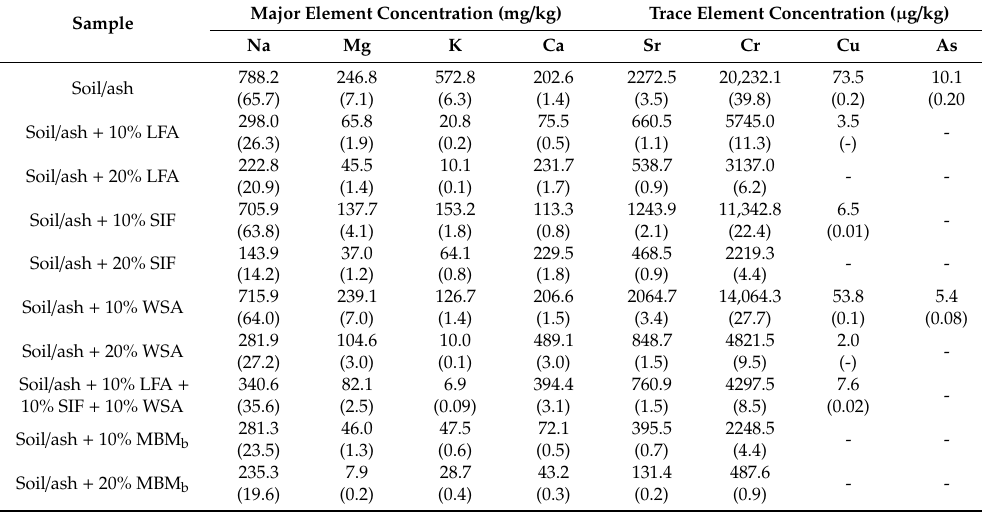
Table 5. Cumulative element concentrations and (%) mass leached in the leachates with stabilizers.